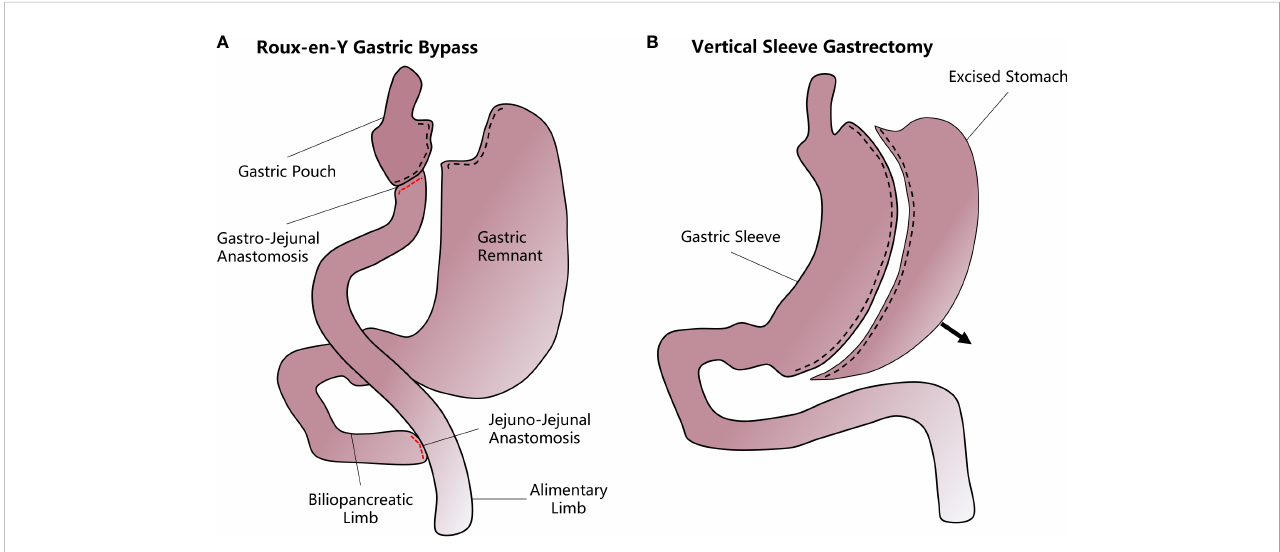
FIGURE 1 A diagram of how vertical sleeve gastrectomy (VSG) and Roux-en-Y gastric bypass (RYGB) are performed. (A) In the RYGB procedure, the upper gastrointestinal tract is transected from near the gastric fundus and the jejunum to form a small gastric pouch. The stomach remnant and the duodenum and proximal jejunum are bypassed and attached to the mid-jejunum through a jejunal-jejunal anastomosis. Another gastro-jejunal anastomosis allows the connection of the gastric pouch and distal jejunum. (B) In VSG, most of the stomach is resected along the greater curvature while the remnant stomach forms a sleeve structure that greatly decreases the accommodative capacity and increases the chyme ’ s diversion